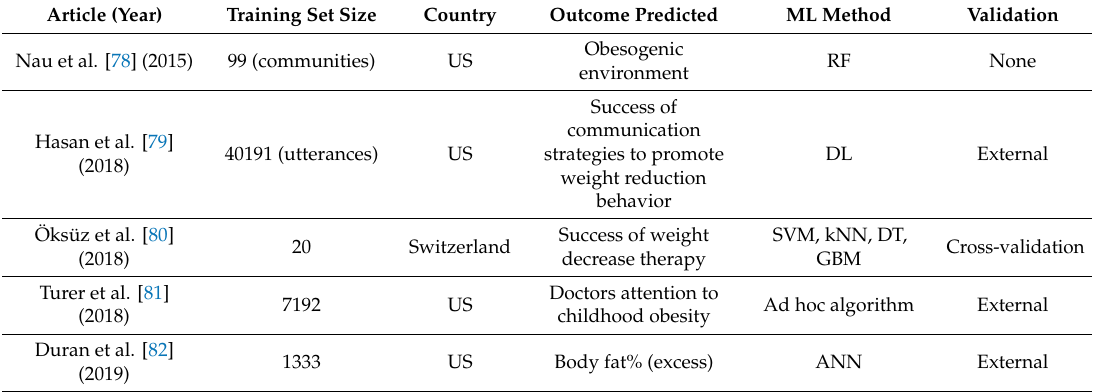
Table 3. Summary of ML models to predict BMI-related